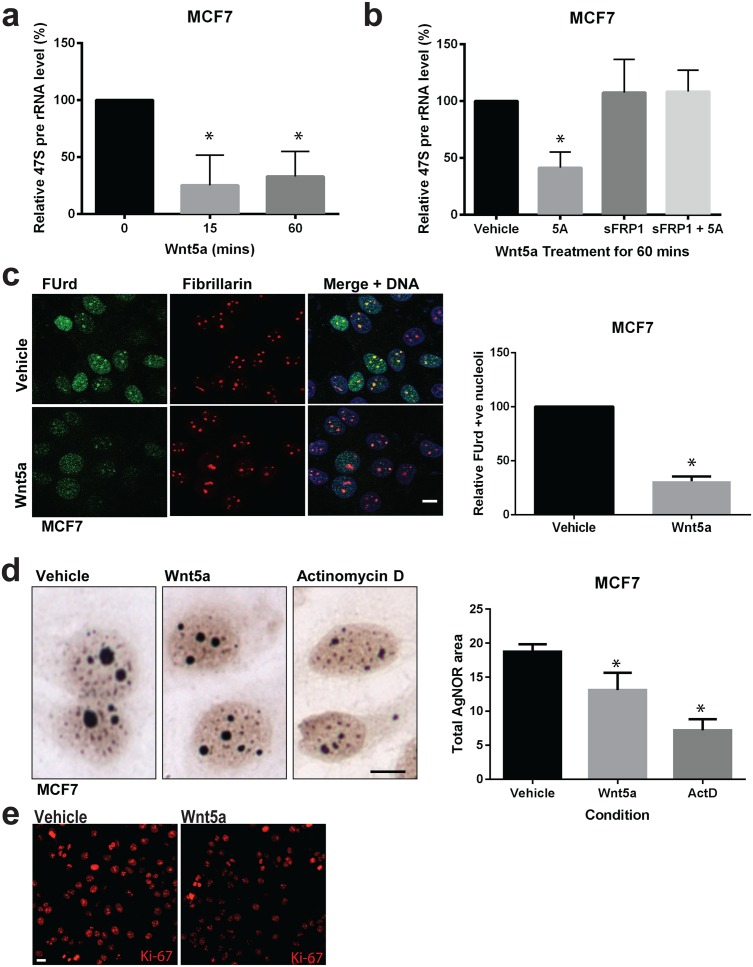
Wnt5a inhibits rRNA gene transcription and reduces the size of nucleoli.(a) Semi-quantitative RT-PCR analysis of 47S pre-rRNA transcript levels in MCF7 cells treated with Wnt5a for the indicated times. Error bars indicate ± SD. *P < 0.05 (n = 3). (b) The inhibitory effect of Wnt5a treatment for 60 mins on 47S rRNA synthesis is prevented by pre-treatment (60 mins) with sFRP1 in MCF7 cells. *P < 0.01 (n = 3). (c)
In situ nuclear run-on assay of 5-Fluorouridine (FUrd) incorporation into nascent transcripts. MCF7 cells were treated with Wnt5a for 20 min and FUrd was detected by immunofluorescence (green). Cells were co-stained for Fibrillarin (red) and DNA (blue) to highlight nucleolar incorporation of FUrd (yellow in merged image). Scale bar = 10 μm. Quantitation of nuclei with bright nucleolar incorporation of FUrd in vehicle- and Wnt5a-treated cells. Error bars indicate ± SD. *P < 0.0001 (n = 3). (d) Silver staining of nucleolar organizer regions (AgNOR) of MCF7 cells treated with vehicle, 200 ng/mL Wnt5a, or 1 μg/mL Actinomycin D (ActD) for 4 hours. Scale bar = 10 μm. Quantification of AgNOR staining showing that Wnt5a and ActD both reduce the area of nucleoli. Error bars indicate ± SD *P <0.05; (n = 3). (e) Confocal immunofluorescence of Ki-67 (red) in MCF7 cells treated with either vehicle or with 200 ng/mL Wnt5a for 4 hours. Scale bar = 10 μm (n = 3).